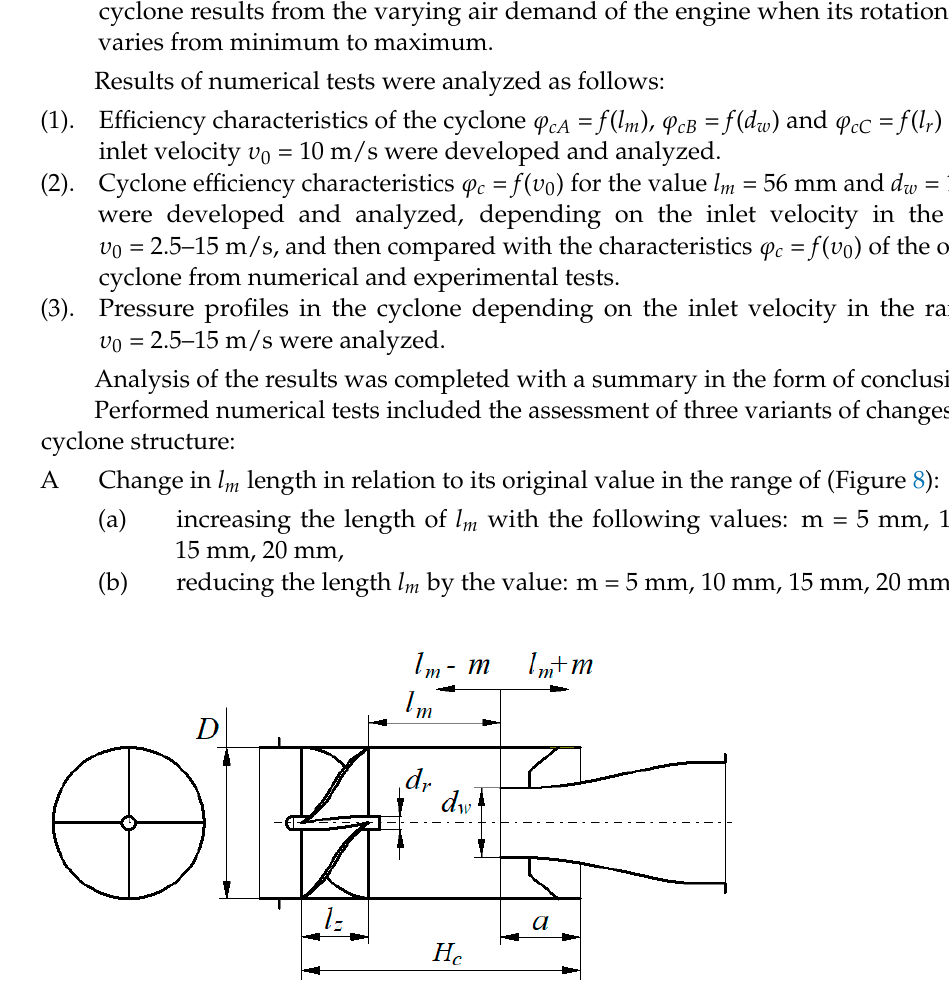
Figure 8. Length change l m in relation to its original value l m = 36 mm.